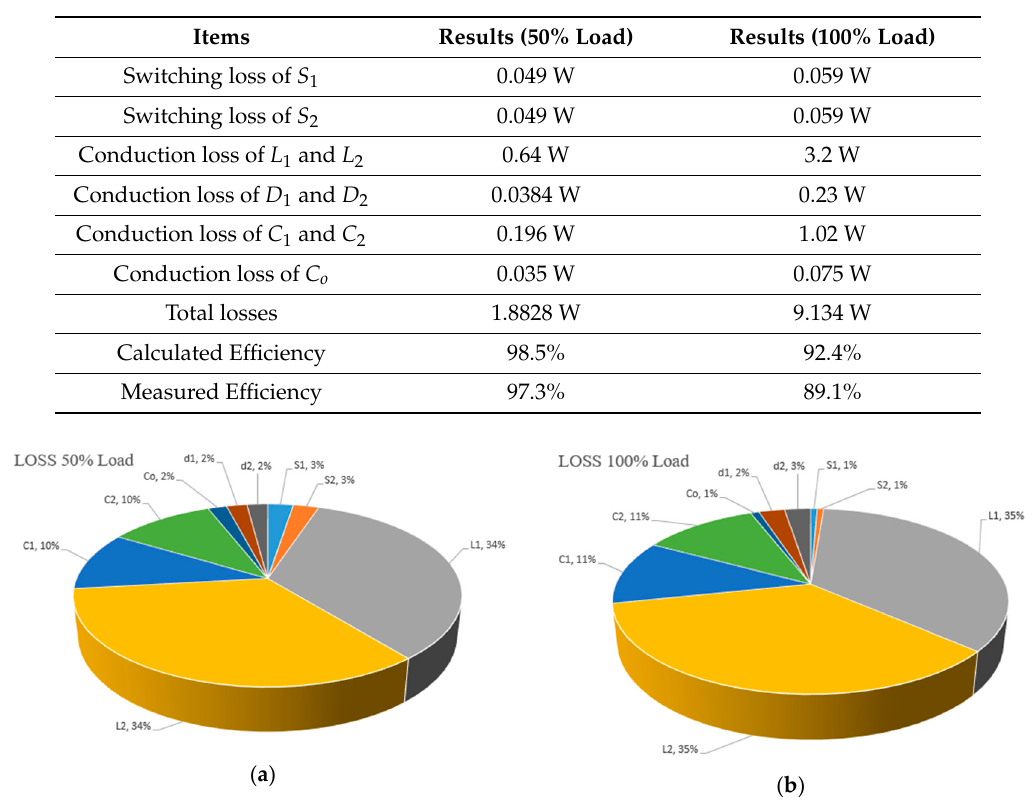
Figure 20. The measured conversion efficiency for the proposed combined boost converter, the conventional boost converter, and the interleaved boost converter with two-phase. Table 5. Parameters of Components.